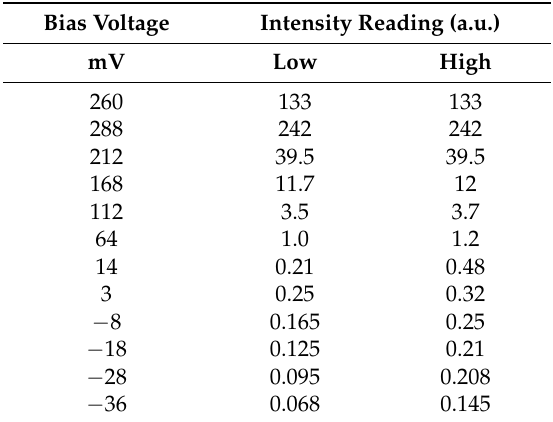
Table 1. Red Emission Intensity Readings for Bias Voltages.